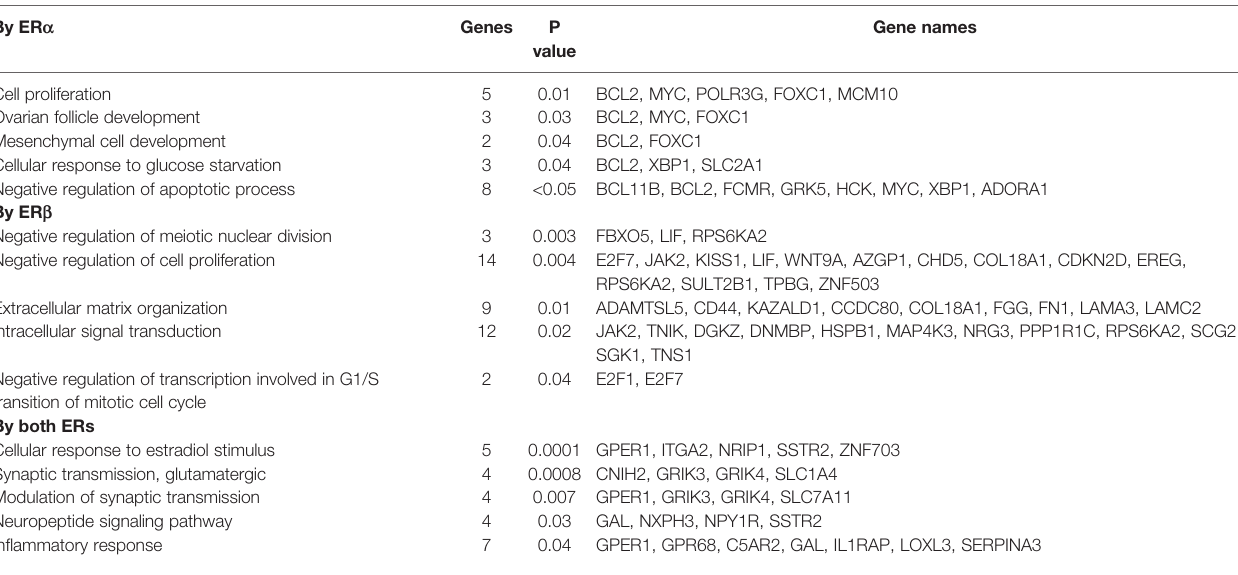
TABLE 1 | GO biological processes analysis for E2-upregulated genes. By ER a Genes P